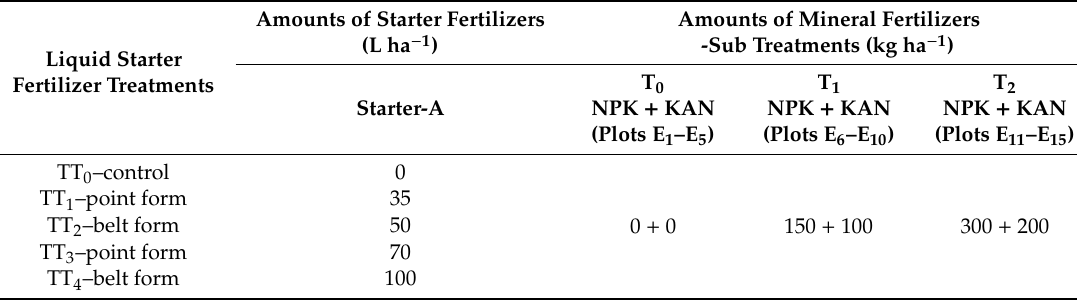
Table 4. Treatments, amounts and techniques of application of applied fertilizers.